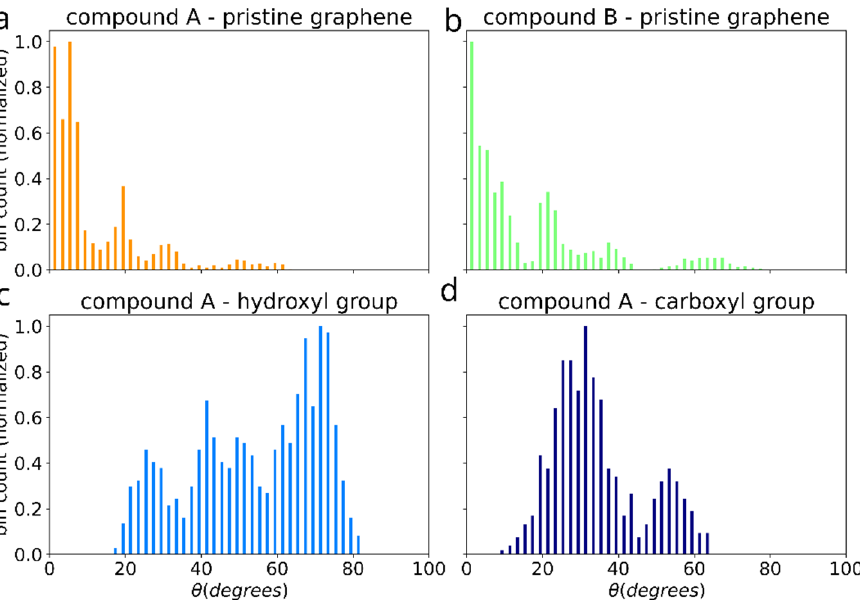
Figure 11. Distribution of the angle between the dimer axis (blue arrow in the Figure 3) and graphene plane for the cases of: pristine graphene with compounds A ( a ) and B ( b ), as well as for compound A adsorbed on graphene with -OH ( c ) and -COOH ( d ) functional groups.